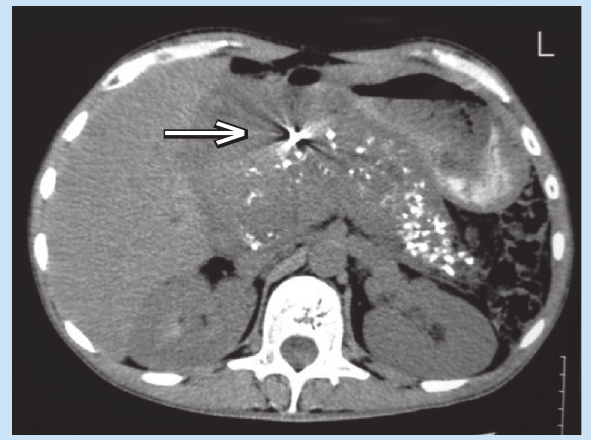
Fig. 2. Common hepatic artery angiography showing gastroduodenal artery pseudoaneurysm (arrow).